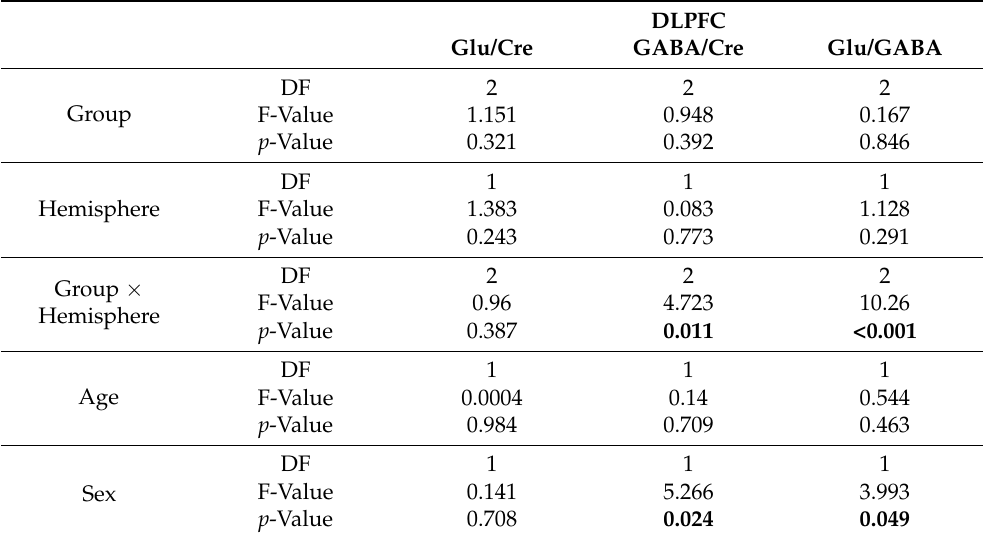
Table 2. Two-way analysis of covariances (ANCOVA) results for Glu/Cre, GABA/Cre, and Glu/GABA. DLPFC Glu/Cre GABA/Cre Glu/GABA DF 2 2 Group F-Value